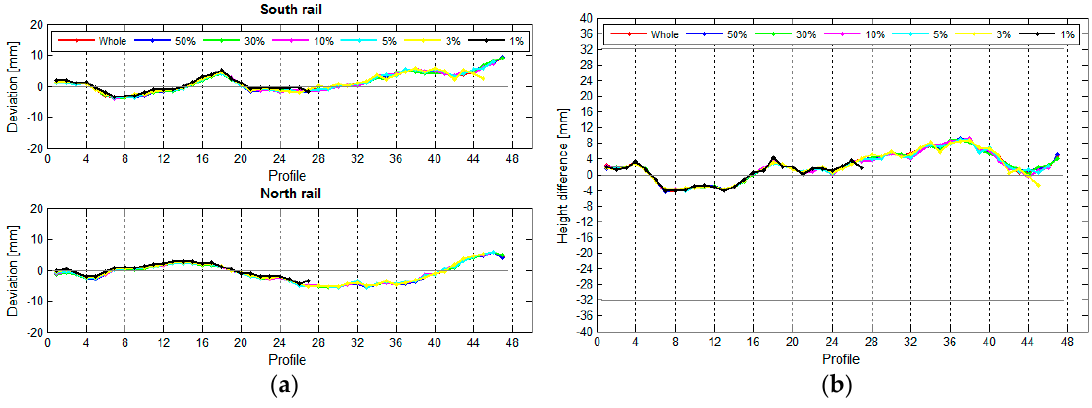
( b ) Figure 23. ( a ) Comparison of the horizontal deviations and ( b ) the spans between the rails. We can see that the horizontal (Figure 23) as well as the vertical (Figure 24) position of the crane rails is similar when measured by both TPS and TLS. We have noticed that the choice of method does not show an important influence on the measurement of the span of the vertical differences between the rails. The inclination of the TLS profile with respect to TPS exists. It is the consequence of the TLS’s inclination sensors, which are not accurate enough. The effect, however, has small influence on the height differences, since the span is significantly shorter than the length of the rails.